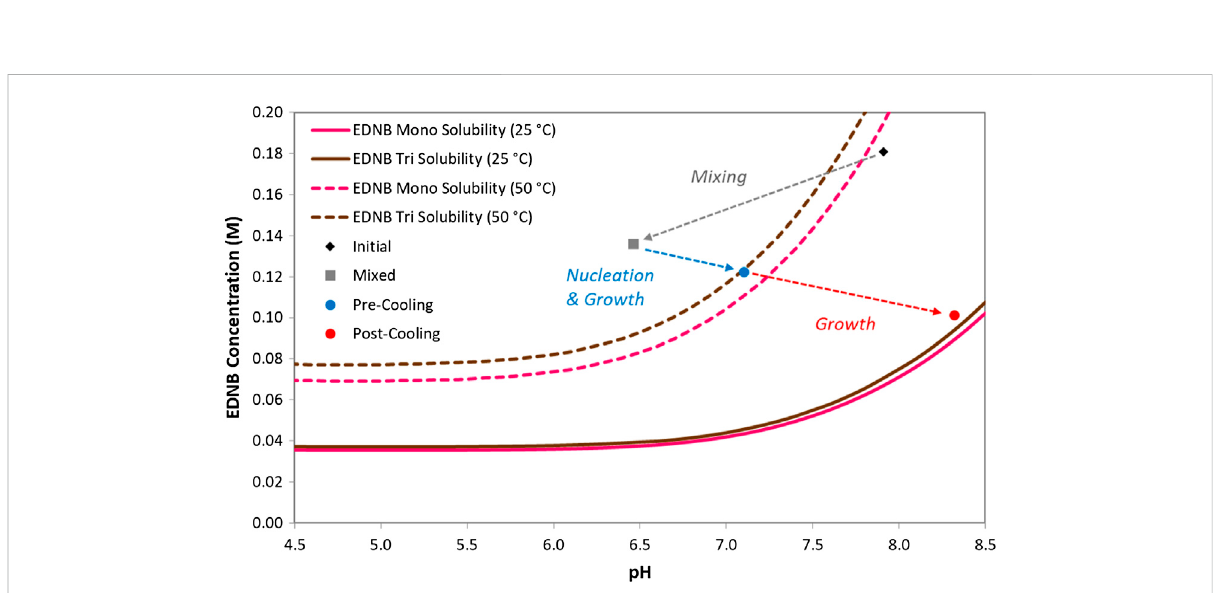
FIGURE 13 Crystallisation process for the continuously pre-mixed semi-batch experiment with